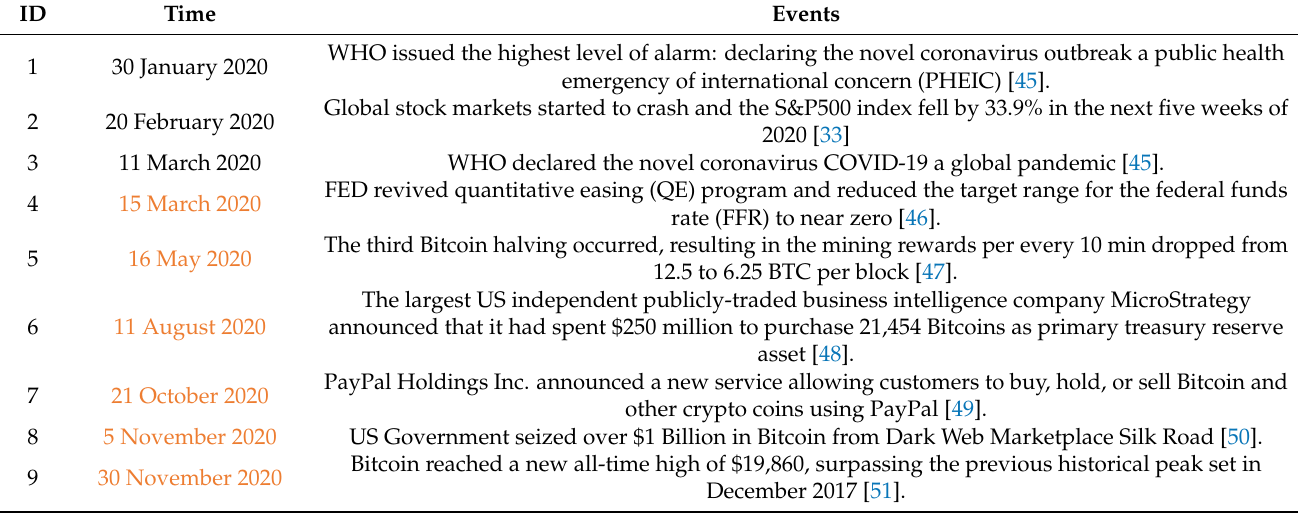
Figure 5. Timeline of main extrinsic events potentially affecting the price of Bitcoin with positive events marked in orange while negative events in black. Table 2. Main extrinsic events that may have affected Bitcoin price from December 2019 to June 2021. Positive and negative events are marked in orange and black, respectively.